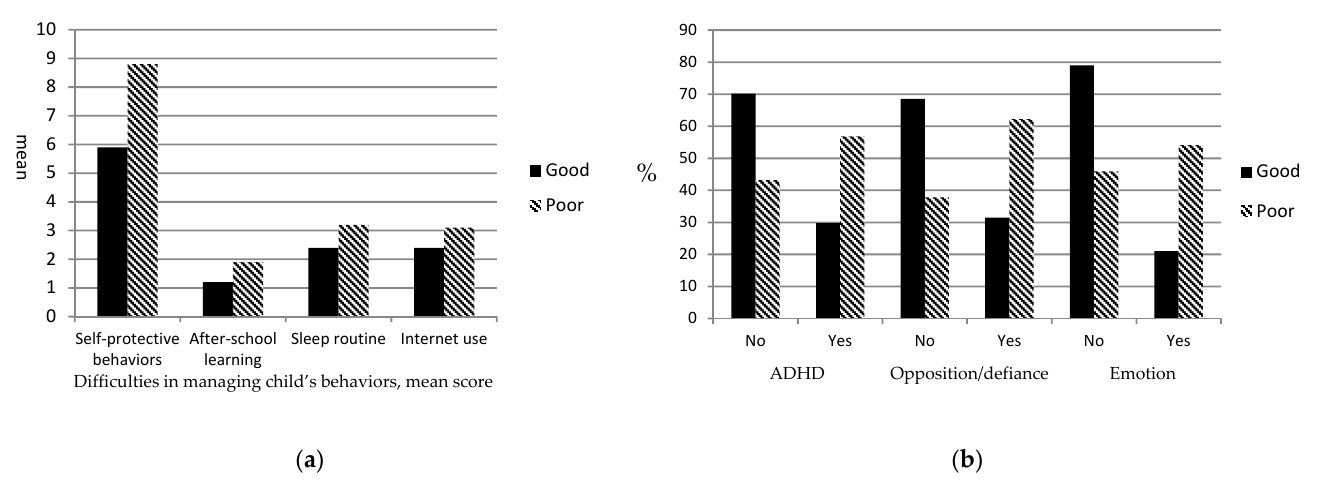
Figure 1. ( a ) Difficulties in Managing Child’s Behavior and ( b ) Worsened Psychological Symptoms between Caregivers with Good and Poor Mental Health.